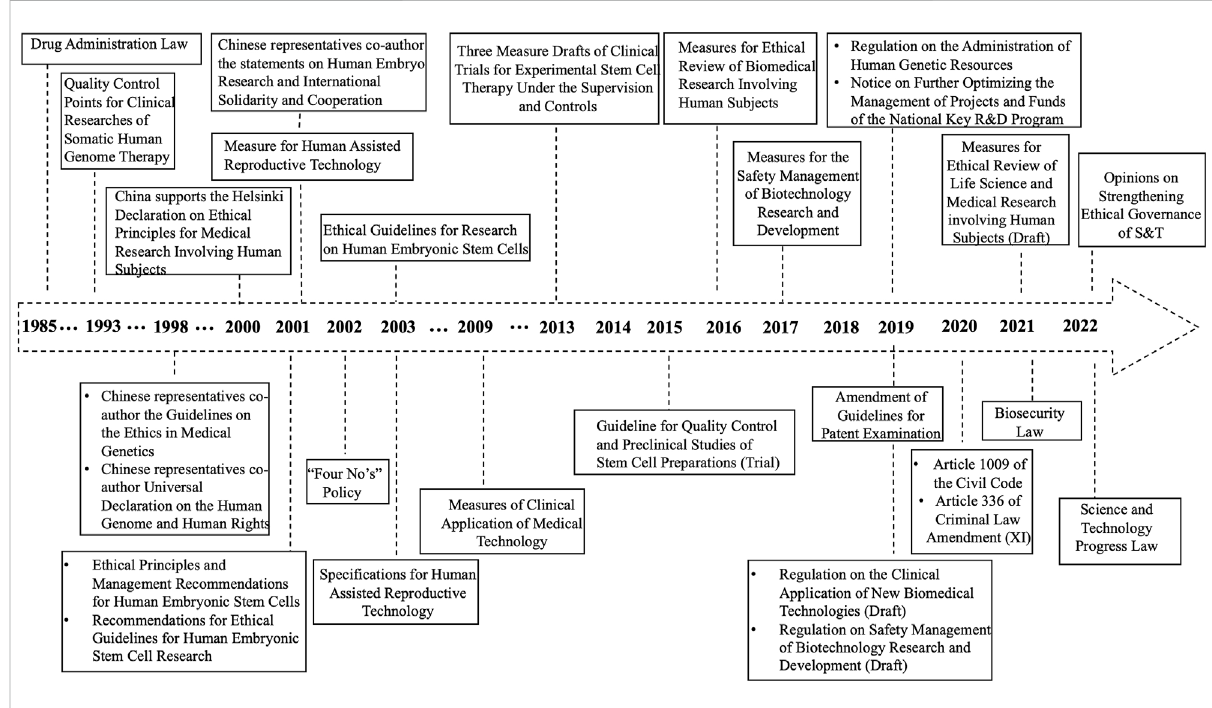
FIGURE 1 Legal Rules for Human Embryos and Embryoid Research in